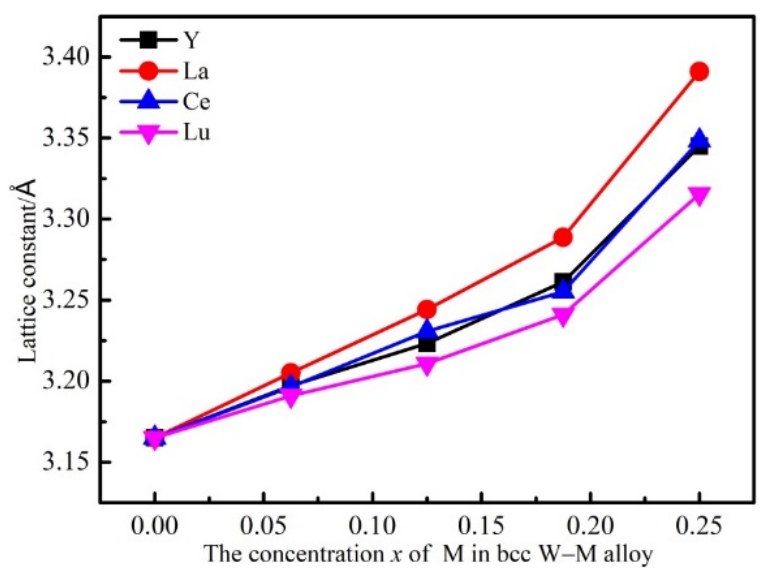
Figure 4. Equilibrium lattice constants of bcc W–M alloys as a function of M concentration.